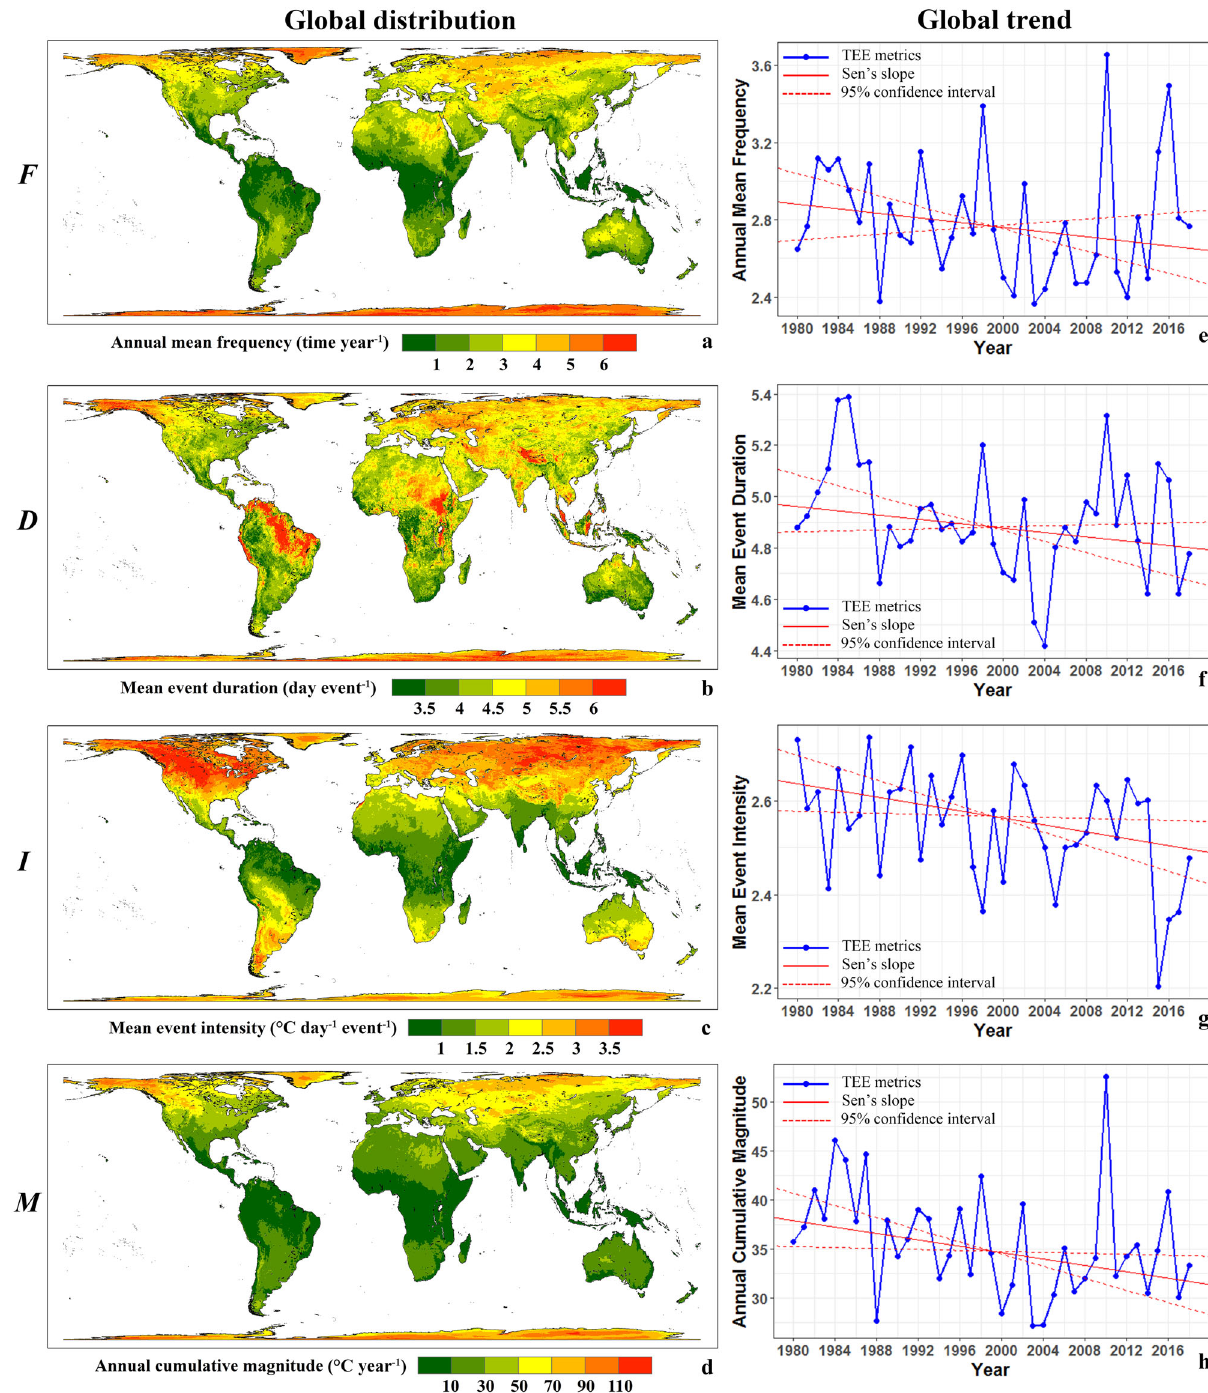
Fig. 1 Global distribution and trends of annual mean frequency ( F ), mean event duration ( D ), mean event intensity ( I ), and annual cumulative magnitude ( M ) for all identi fi ed temperature extreme events (TEEs). a – d Global distribution of F , D , I and M . e – h Global trends of F , D , I and M . Trends were estimated for 1980 – 2018 using Mann – Kendall test and Theil – Sen